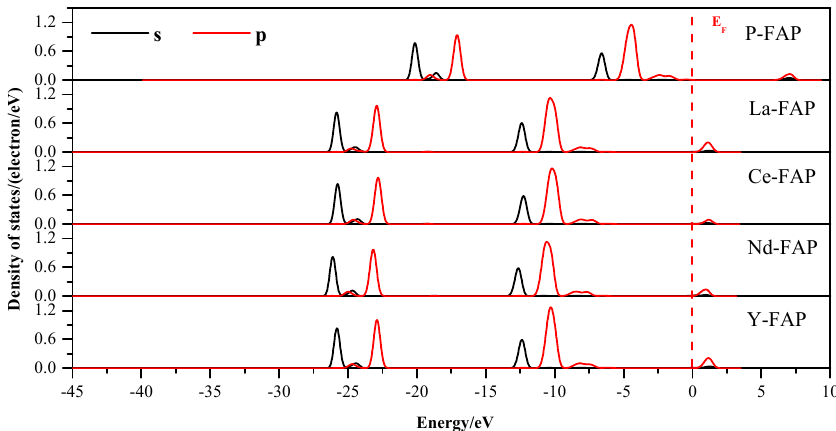
Figure 10. PDOS of a single P atom adjacent to the rare earth atom in REE-FAP crystals.